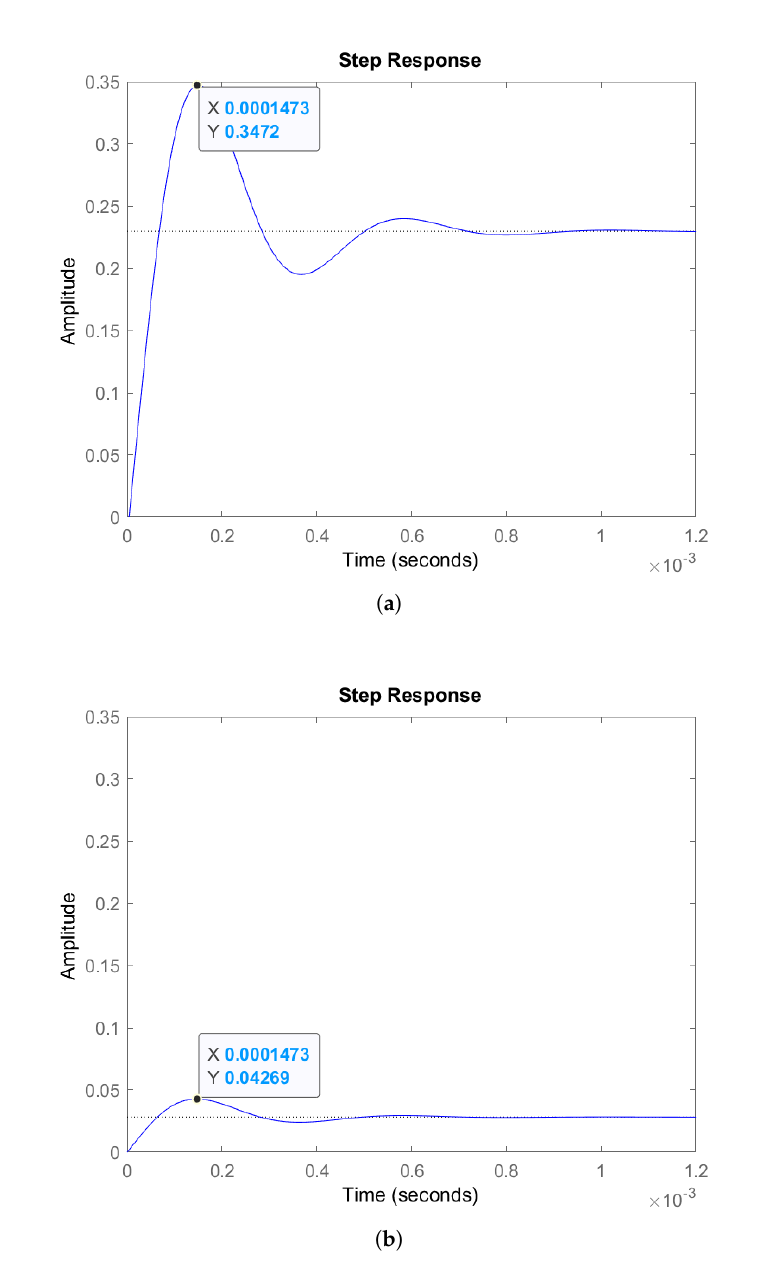
Figure 3. ( a ) Step response of v o , ac due to d ac